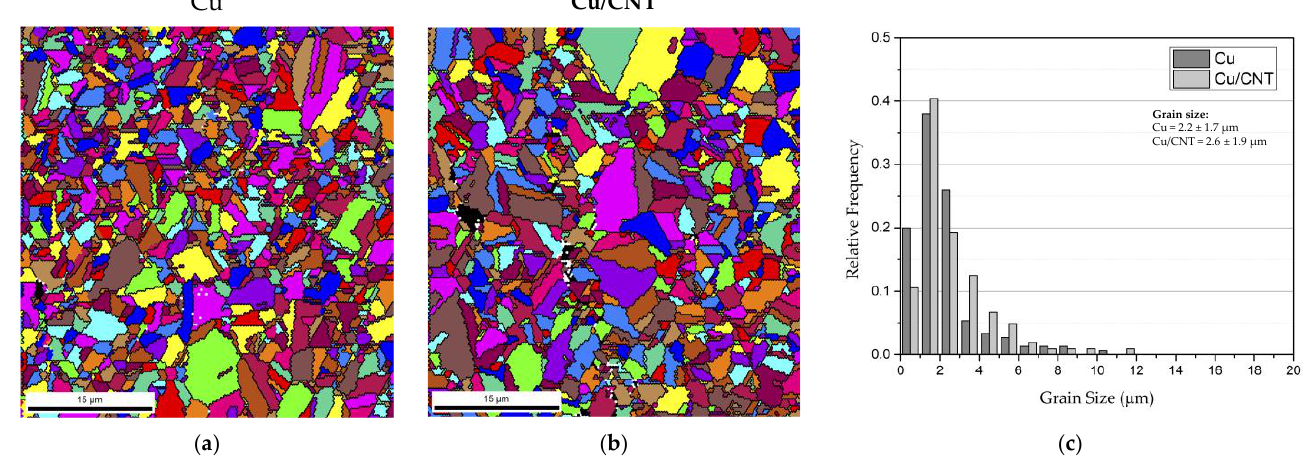
Figure 9. Unique color grain maps of ( a ) Cu matrix and ( b ) Cu/CNT nanocomposites, and ( c ) grain size distribution of Cu matrix and Cu/CNT nanocomposite sintered samples.